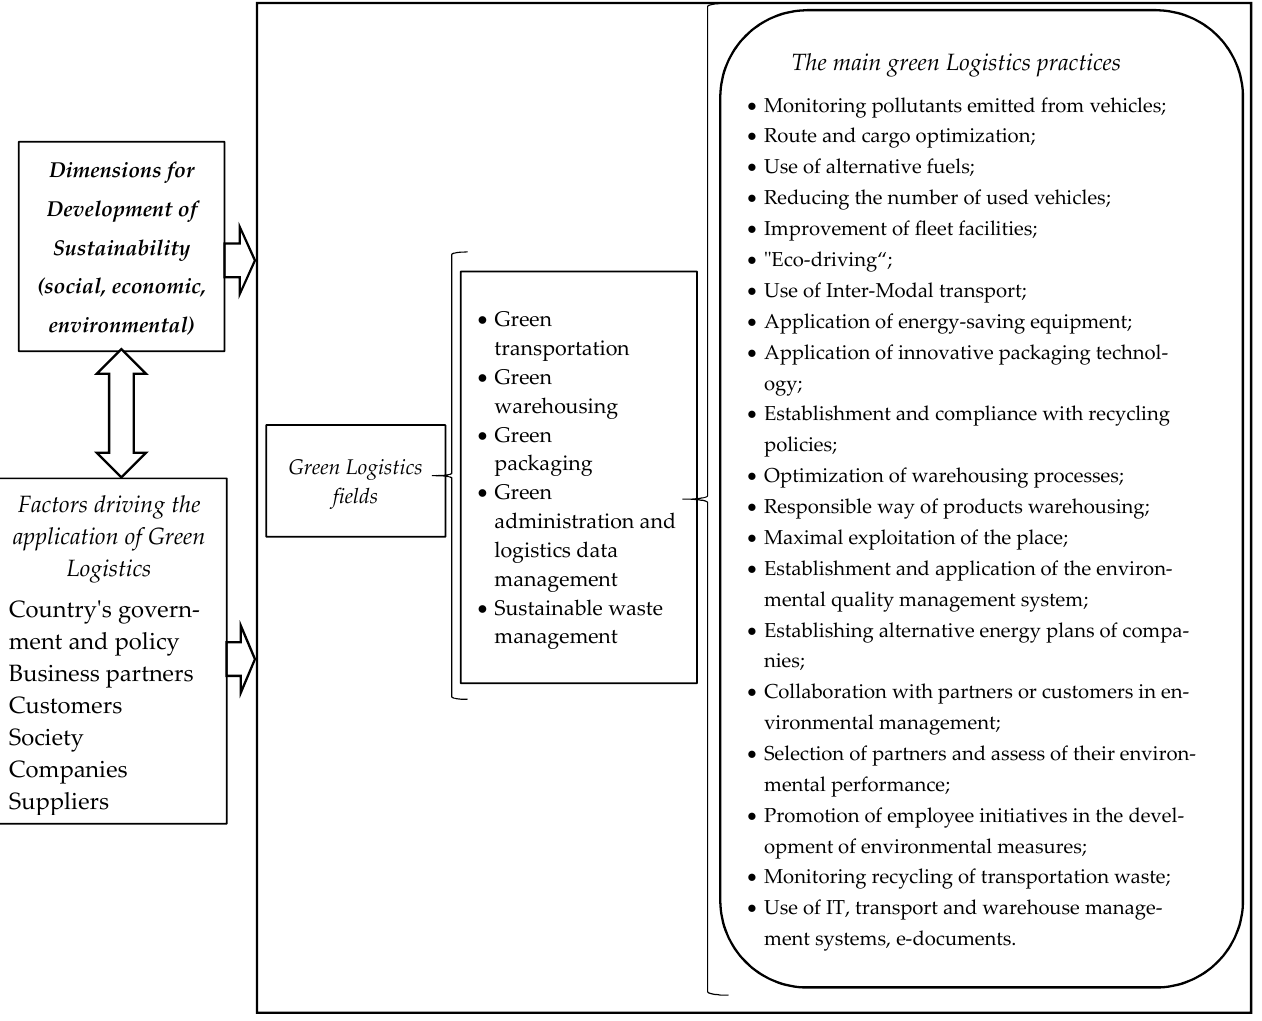
Figure 1. Theoretical conceptual model of green logistics practices seeking development of sustainability.